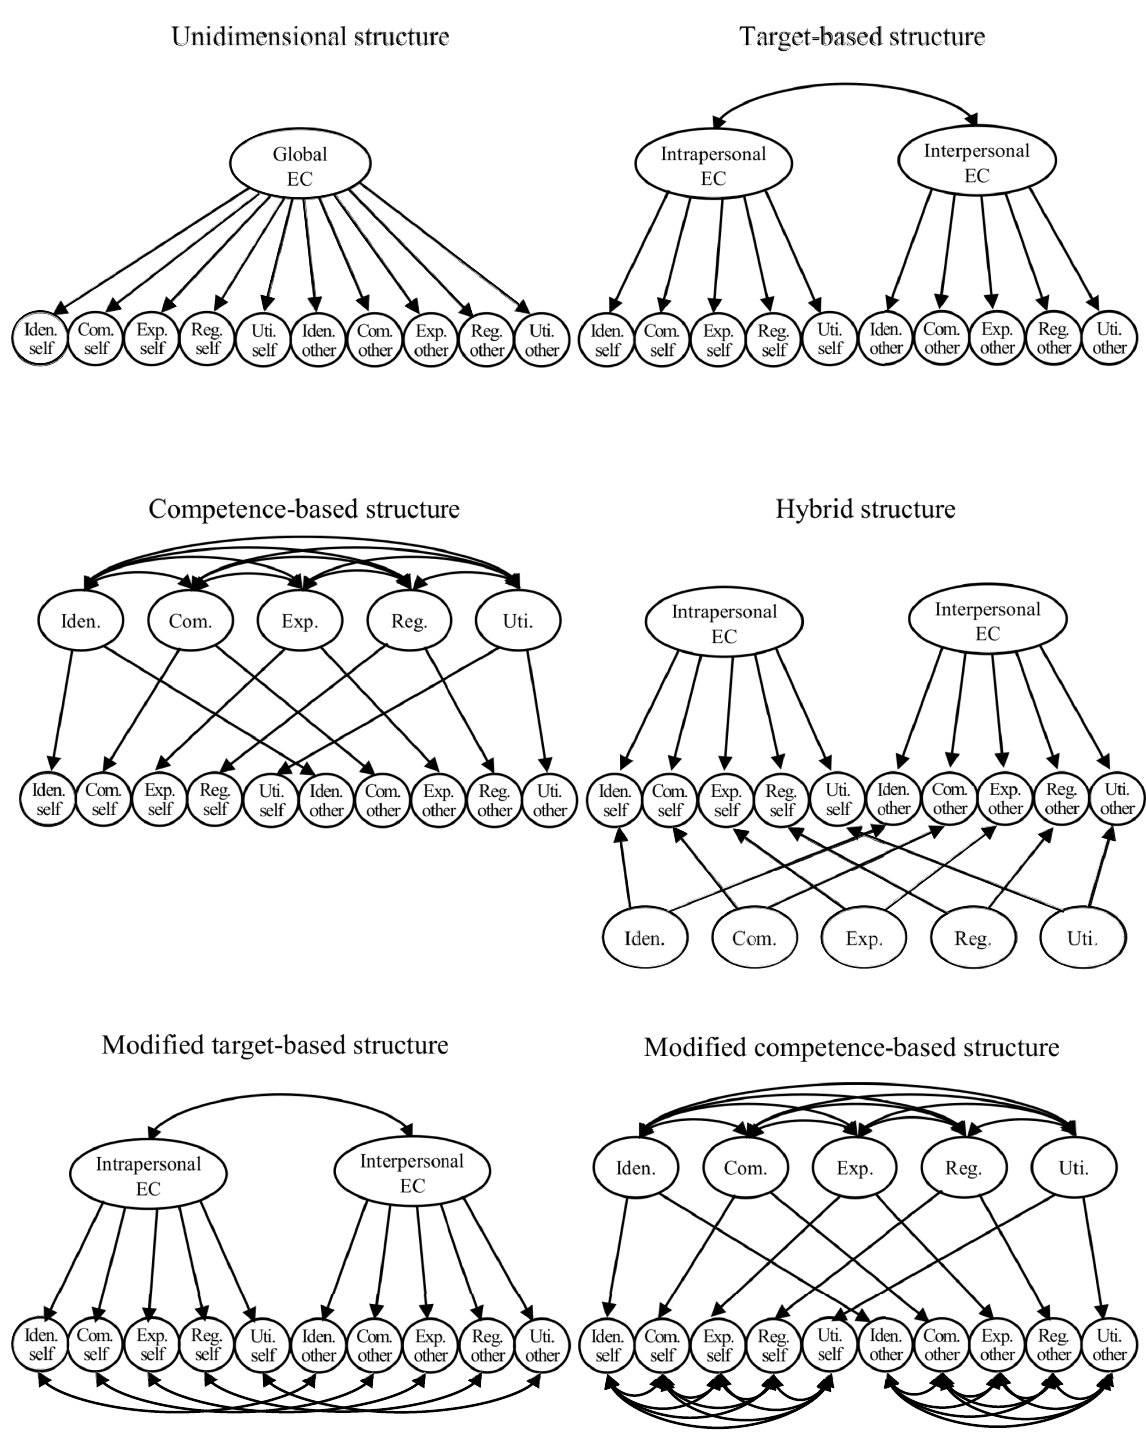
Fig 1. Candidate factorial models for emotional competence. EC: emotional competence, Iden.: emotion identification, Com.: emotion comprehension, Exp.: emotion expression, Reg.: emotion regulation, Uti.: emotion utilization.